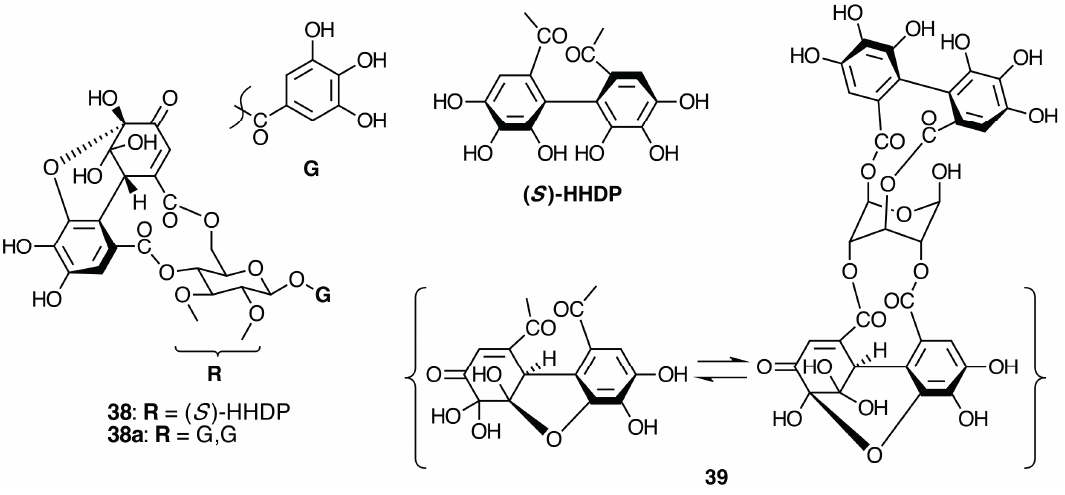
Figure 18. Ellagitannins with modified HHDP